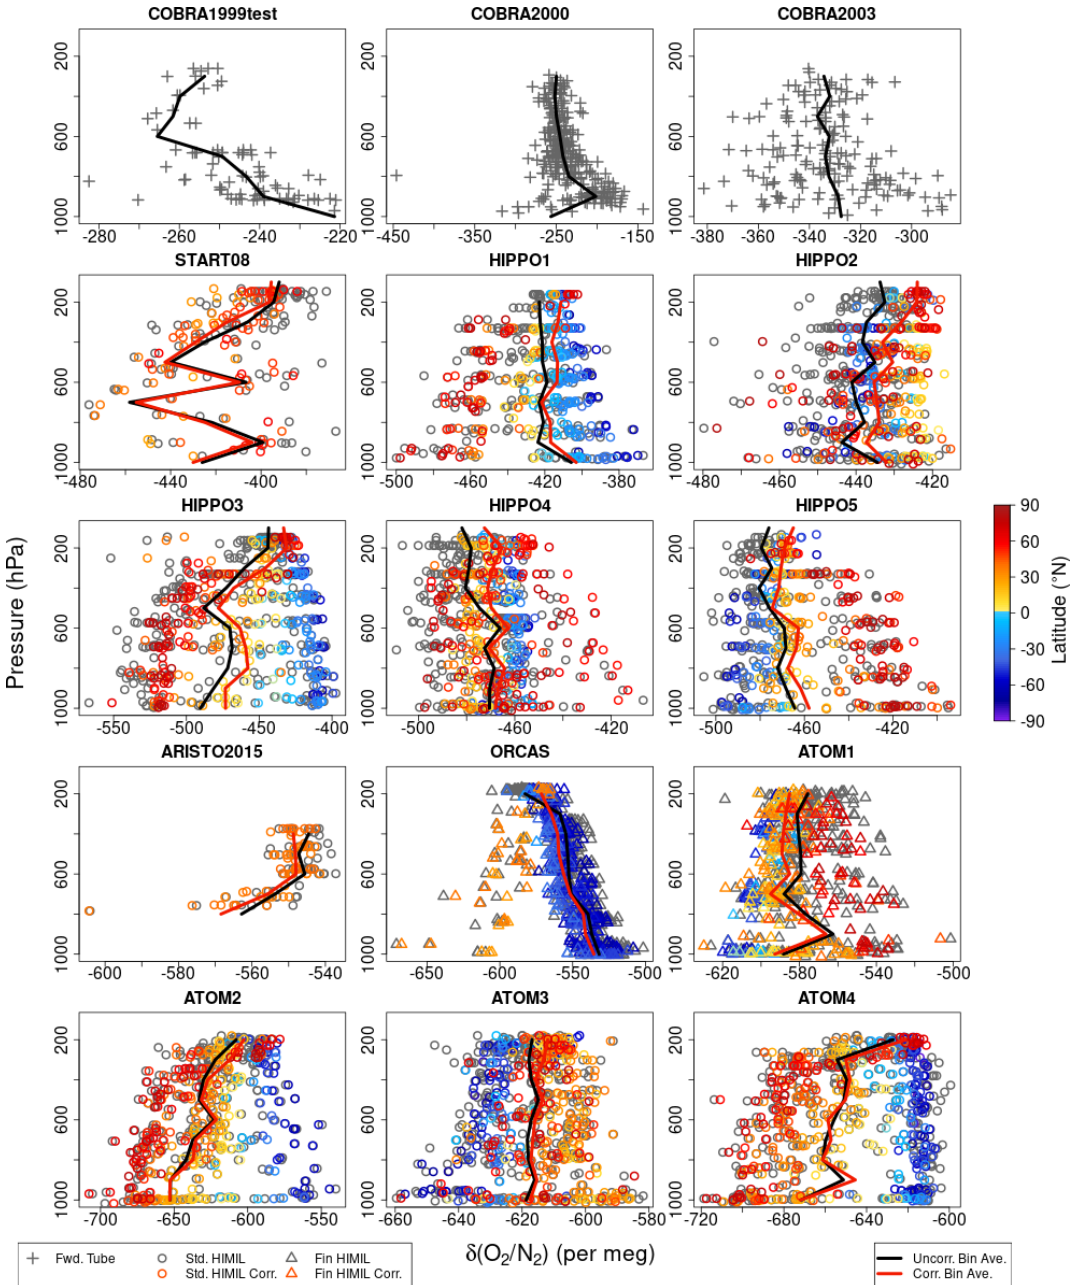
Figure 7. Measurements of δ (O 2 / N 2 ) and δ (O 2 / N 2 ) ∗ on Medusa flasks for each campaign plotted versus pressure and colored by latitude. Symbol shapes distinguish the different Medusa inlet types. Gray symbols show the original uncorrected δ (O 2 / N 2 ) measurements. Colored symbols show δ (O 2 / N 2 ) ∗ data after correction for thermal or inlet fractionation effects using δ (Ar / N 2 ). We have not calculated δ (O 2 / N 2 ) ∗ for the COBRA campaigns. Black lines show δ (O 2 / N 2 ) averages for 100hPa bins. Red lines show bin averages for δ (O 2 / N 2 ) ∗